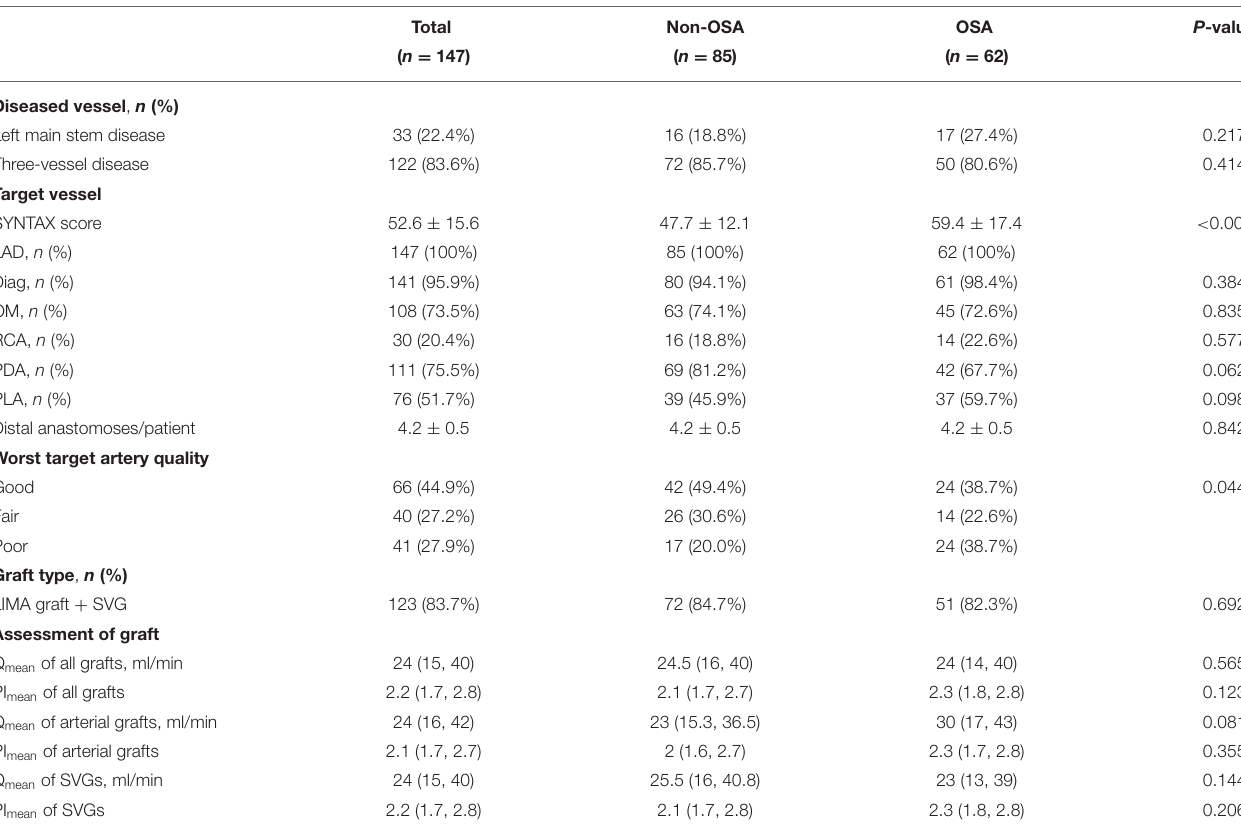
TABLE 3 | Angiographic and surgical